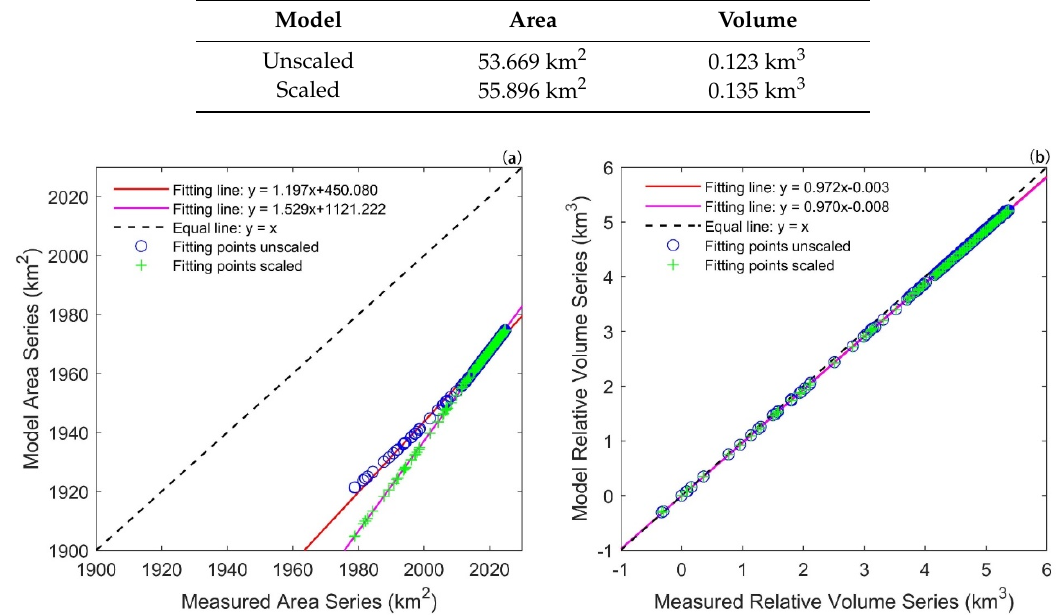
Figure 10. The fitting result of the ( a ) area and ( b ) volume series between the Hydroweb data and the proposed model.